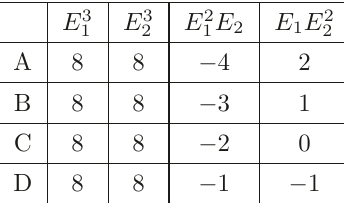
Table 2 . The triple intersection number of the compact divisors for the toric diagrams in figure 10.